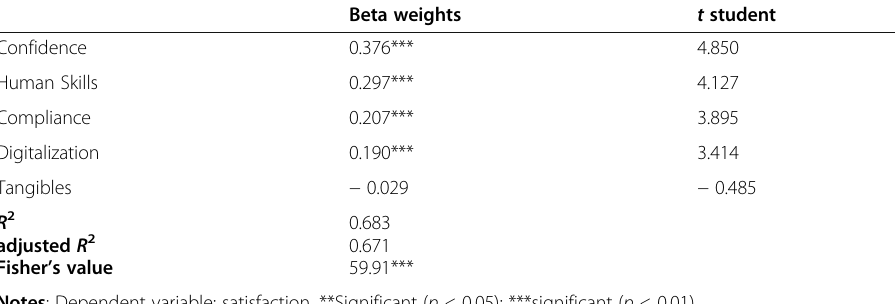
Table 7 Relationships between service quality factors and